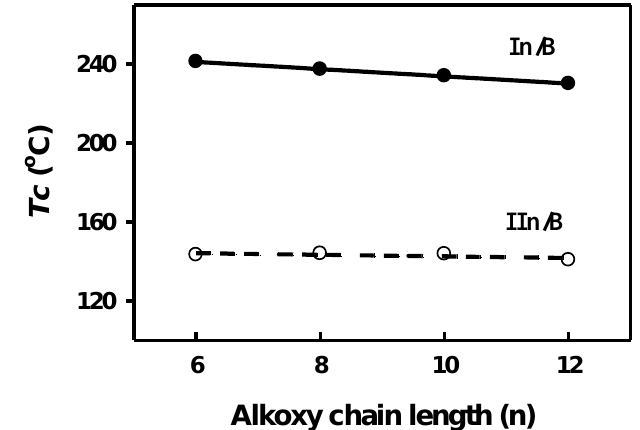
Figure 6. Comparison between the present SMHB In/B complexes (●) and five-ring IIn/B system ( ○ ) in nematic stability.